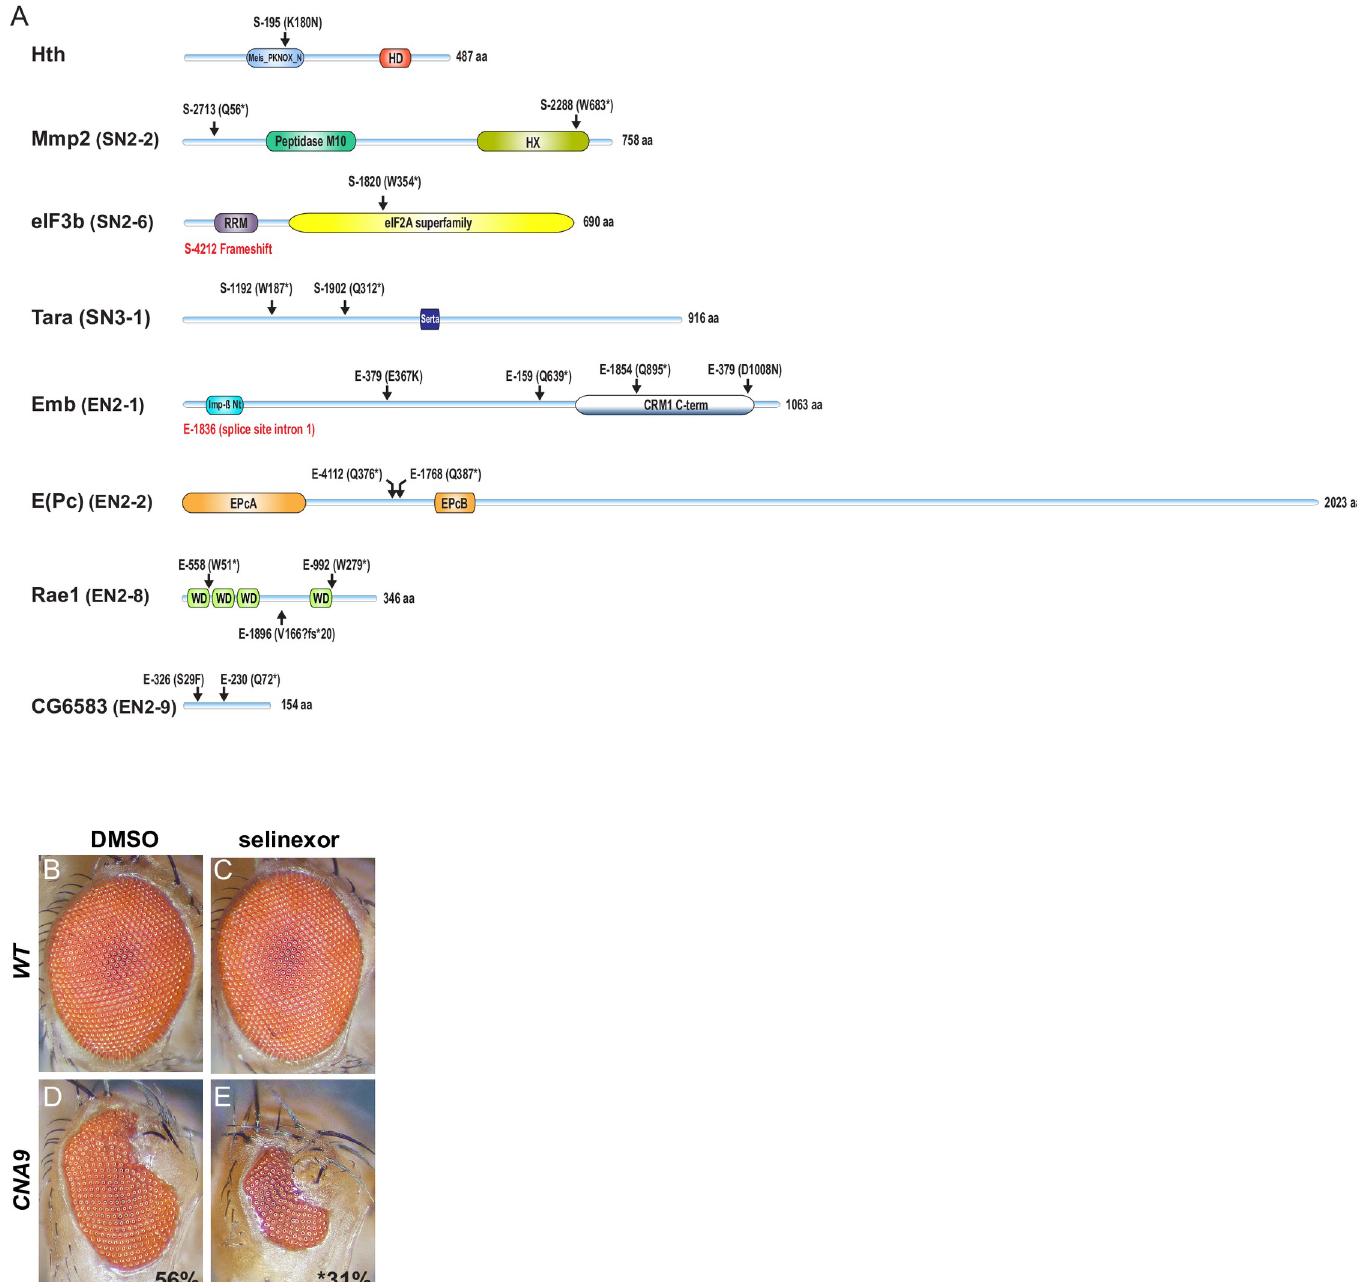
Fig 4. Molecular lesions associated with eight modifiers of NA9. (A) Schematic representations of proteins encoded by loci identified in the screen. Domain compositions were defined according to the Conserved Domains tool at the National Center for Biotechnology Information (NCBI)). The position of amino acid changes for the indicated sequenced alleles is shown on top of each protein schematics. Asterisks denote STOP codons. (B-E) Micrographs of adult eyes of the following genotypes: (B, C) Oregon R flies denoted as WT and (D, E) CNA9/+ denoted as CNA9 . Developing flies were treated with DMSO (B and D) or selinexor (C and E). Mean eye size (expressed as percent compared to WT ), is indicated at the bottom right of CNA9 panels. The experiment was conducted in triplicate and at least five eyes have been analyzed per condition. Statistical significance ( � ; p � 4.2E-07) of eye size difference between DMSO versus selinexor-treated CNA9 flies (D, E) was assessed using a Student’s t